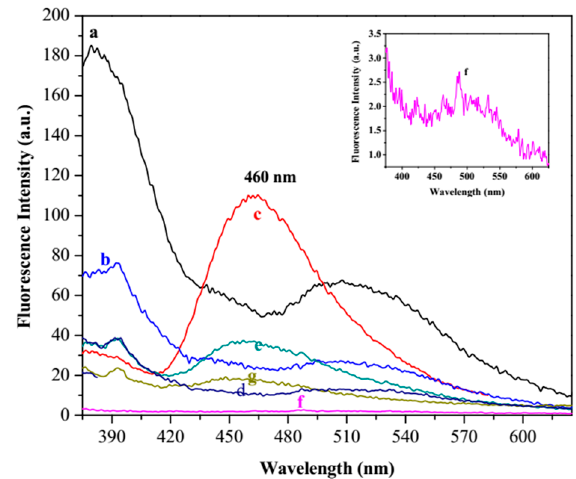
Figure 8. Comparative fluorescence spectra of (a) hpbtz , (b) Fe 3 O 4 -H@hpbtz, (c) Fe 3 O 4 -H@hpbtz + Zn 2+ , (d) Fe 3 O 4 -C@hpbtz, (e) Fe 3 O 4 -C@hpbtz + Zn 2+ , (f) Fe 3 O 4 @hpbtz, and (g) Fe 3 O 4 @hpbtz + Zn 2+ , upon the addition of Zn 2+ (7.8 equivalent, 300 µL), at a concentration of 10 − 3 M in an ethanol solution ( λ ex = 350 nm) (Inset: f in higher concentration, 3 mg mL − 1 ).